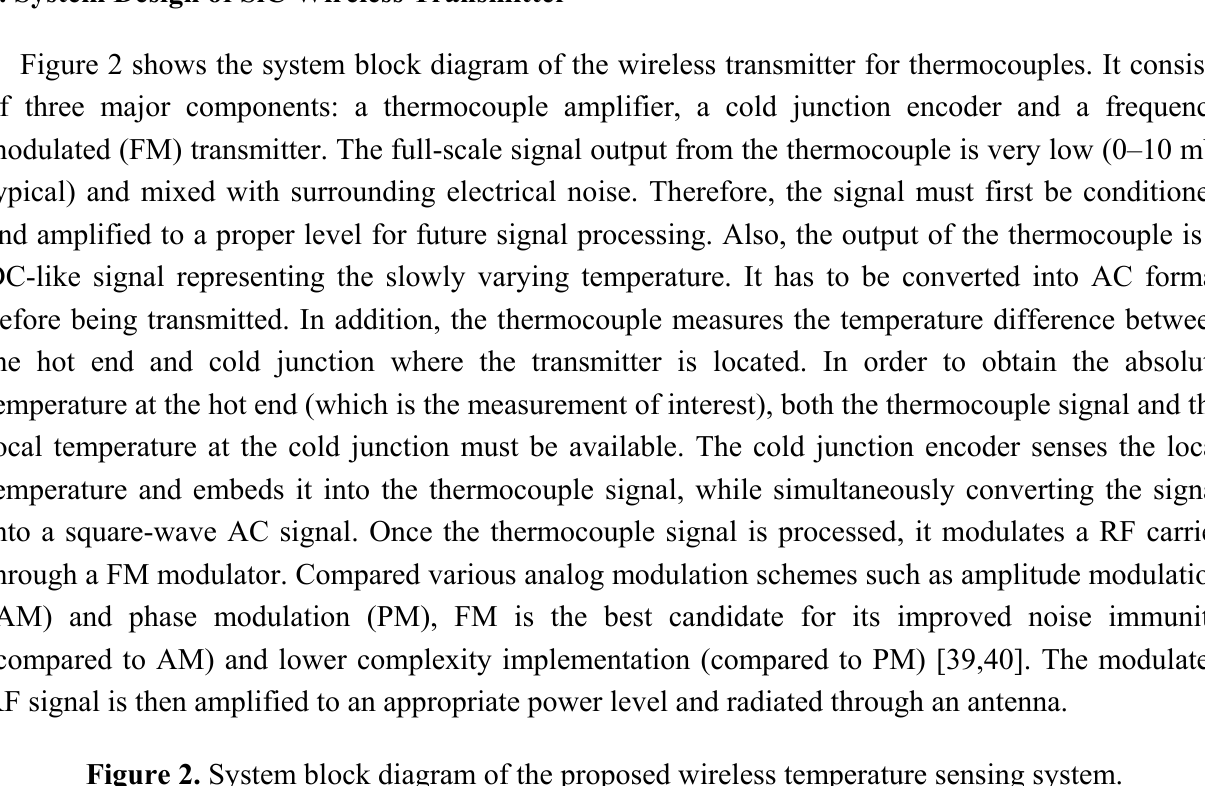
Figure 2. System block diagram of the proposed wireless temperature sensing